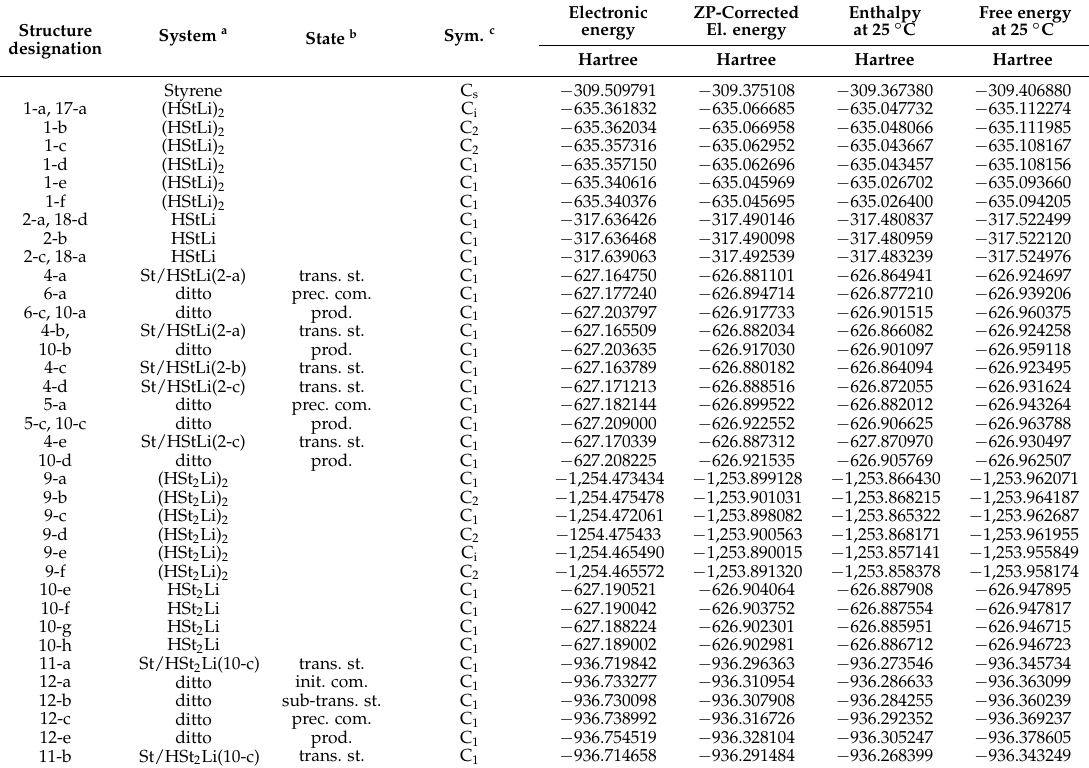
Table A1. Calculated electronic energies, zero-point(ZP)-corrected electronic energies, enthalpies and Gibbs free energies at 25 ◦ C in the gas phase for HStLi and HSt 2 Li, their dimers, and intermediates and products of their reaction with